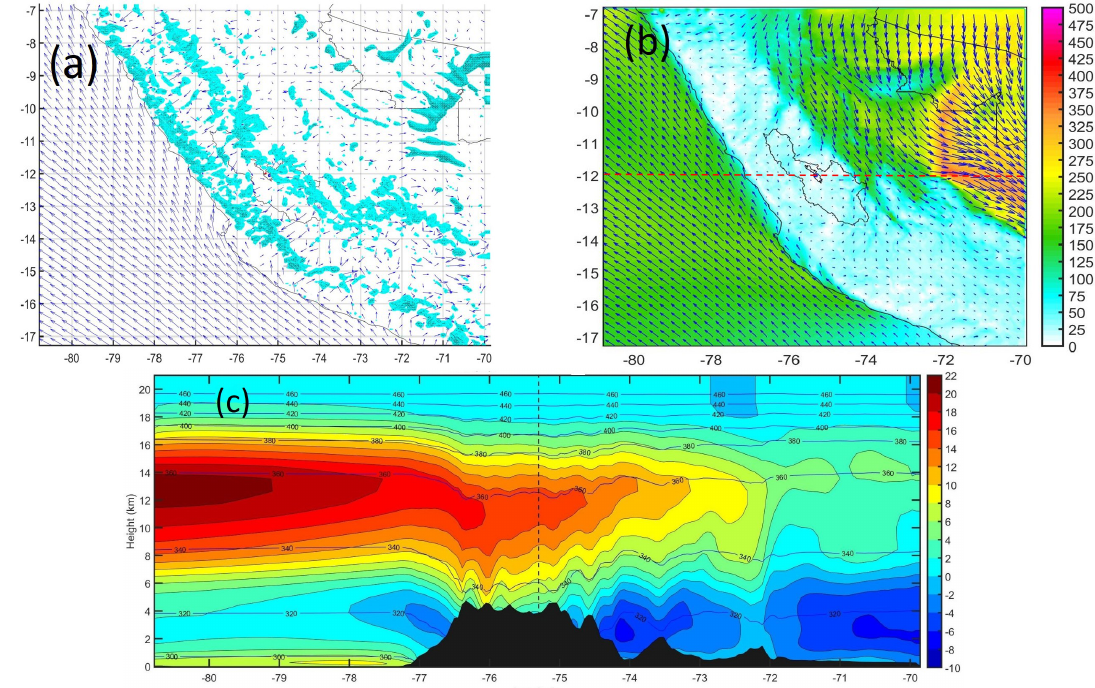
Figure 8. ( a ) Horizontal flow of surface wind (m s − 1 ) and combined issosurface of cloud, ice, rain and hail mixing ratios ( q c + q i + q h + q s ) (0.5 g kg − 1 ); ( b ) Horizontal flow of vertically integrated total column of water vapor flux (kg m − 1 s − 1 ) over the central region of South America. The red lines indicate latitudes for the mean of vertical cross section. The geographic boundaries of the Mantaro basin and the Mantaro valley are indicated; ( c ) Vertical cross section of mean average meridional velocity (m s − 1 ) between 11.9 ◦ S and 12.1 ◦ S. All fields were obtained from the WRF model (resolution: 18 km ( a , b ) and 6 km ( c )) for the convective event TS1 at 18 UTC (13 LT) centered above the Huancayo observatory, which is highlighted with a dotted vertical